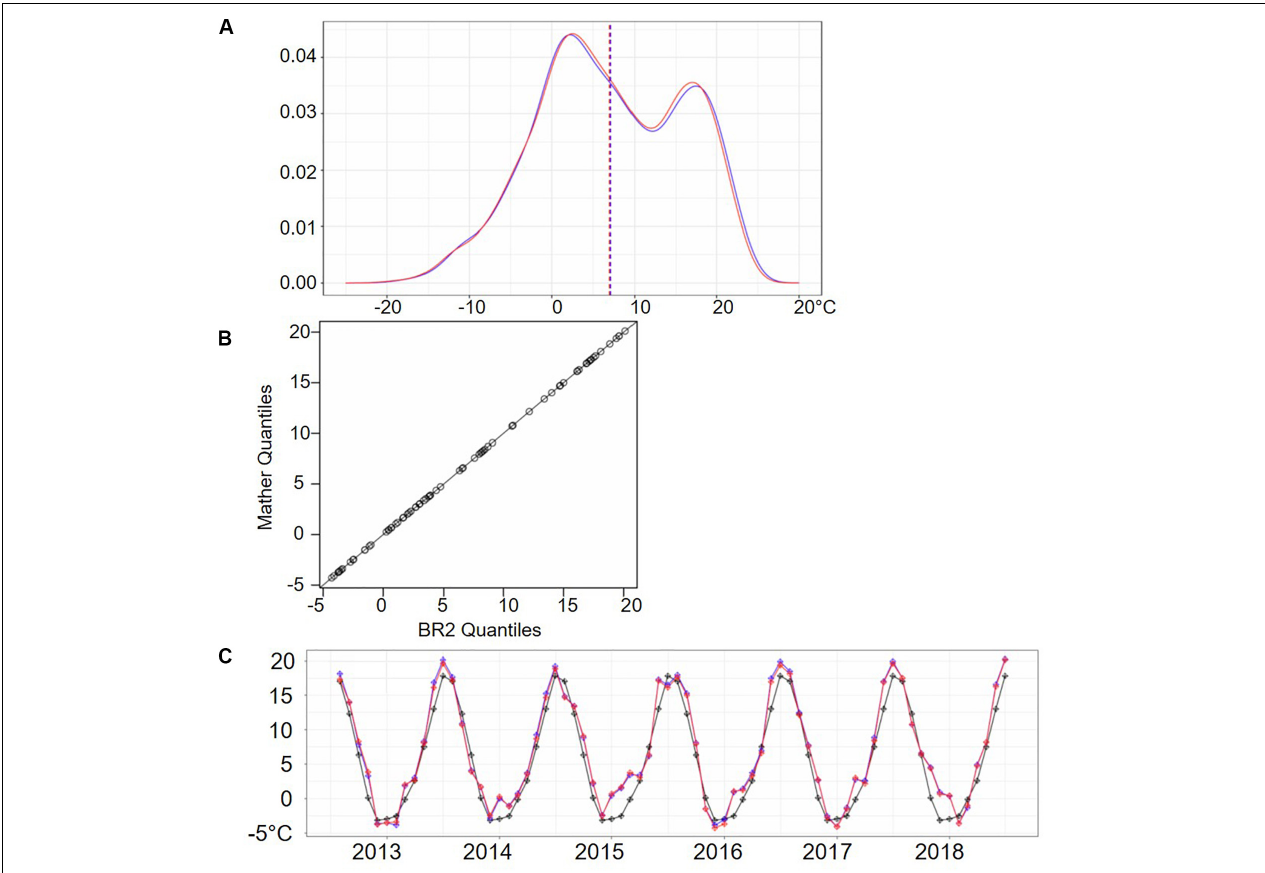
FIGURE 4 | (A) Density plot comparing daily T mean of Lascar sensor (blue) and MWx Station sensor (red). Mean values of each distribution are shown with dashed line. (B) Q-Q plot displaying monthly T mean from MWx data and the BR2 Lascar sensor. Line displays 1:1 value ratio. (C) Monthly T mean timeseries from 2012 to 2018, depicting monthly values for BR2 sensor (blue), MWx Station (red), and PRISM 30-year normals (black). Deviations in the BR2 and MWx trends correspond to the PRISM 30-year